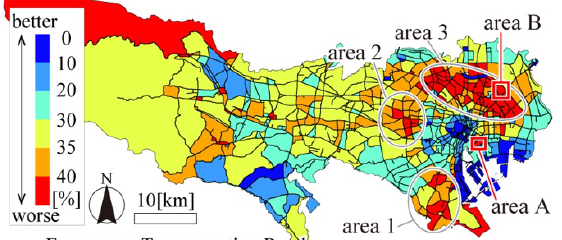
Figure 9. Spatial distribution of old wooden building ratio; the ratio of old wooden building ratio to total number of